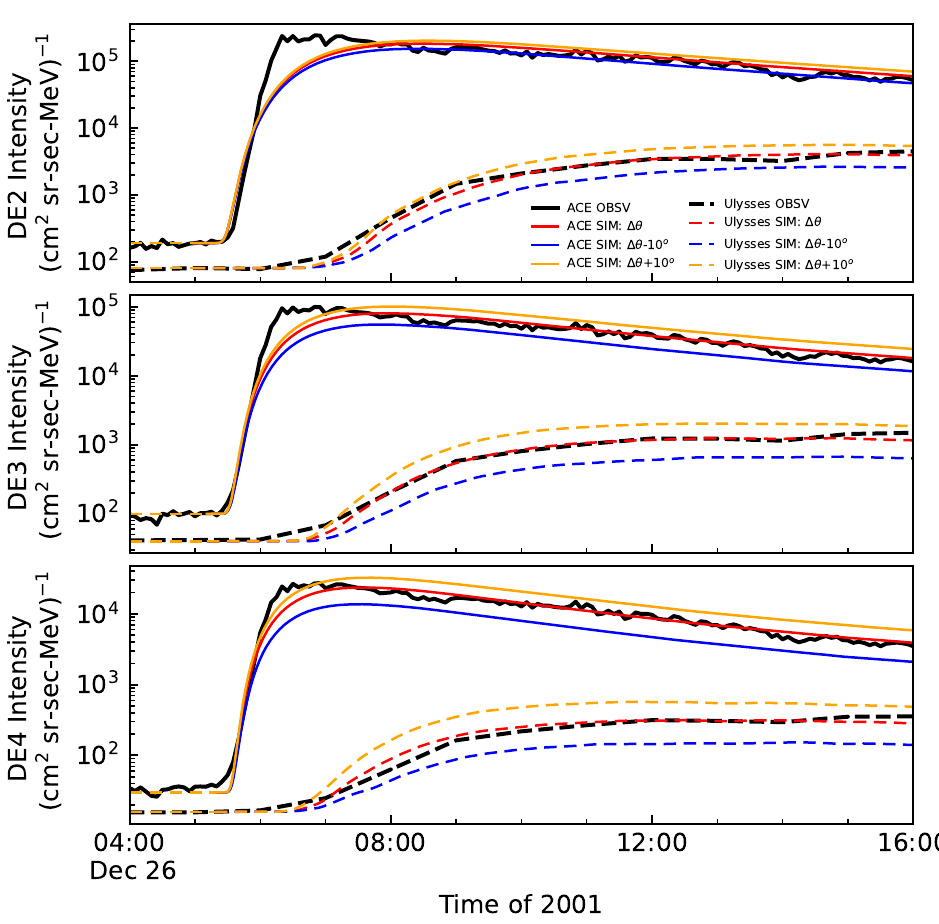
Figure 11. The simulation results with different half width of particle source in 26 December 2001 SEP